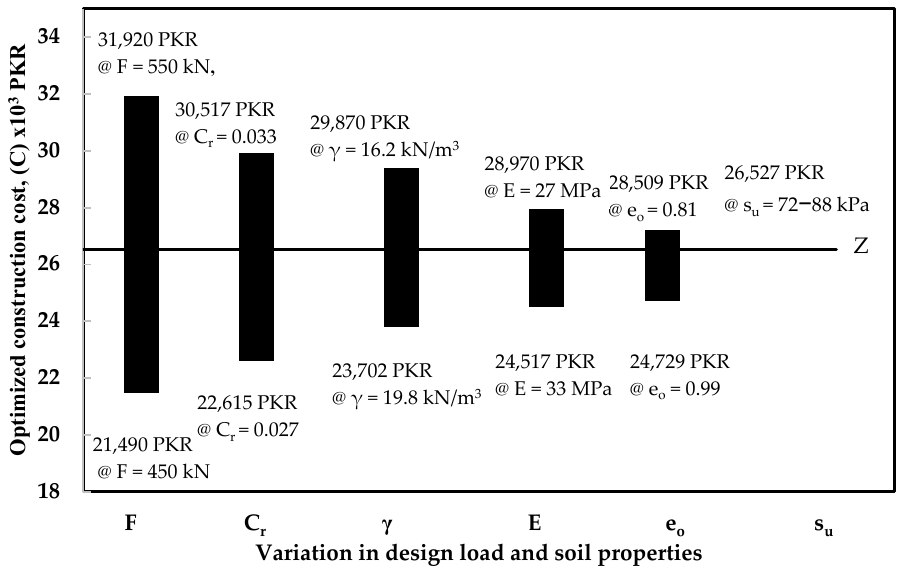
Figure 7. Sensitivity analysis with ± 10% variation.